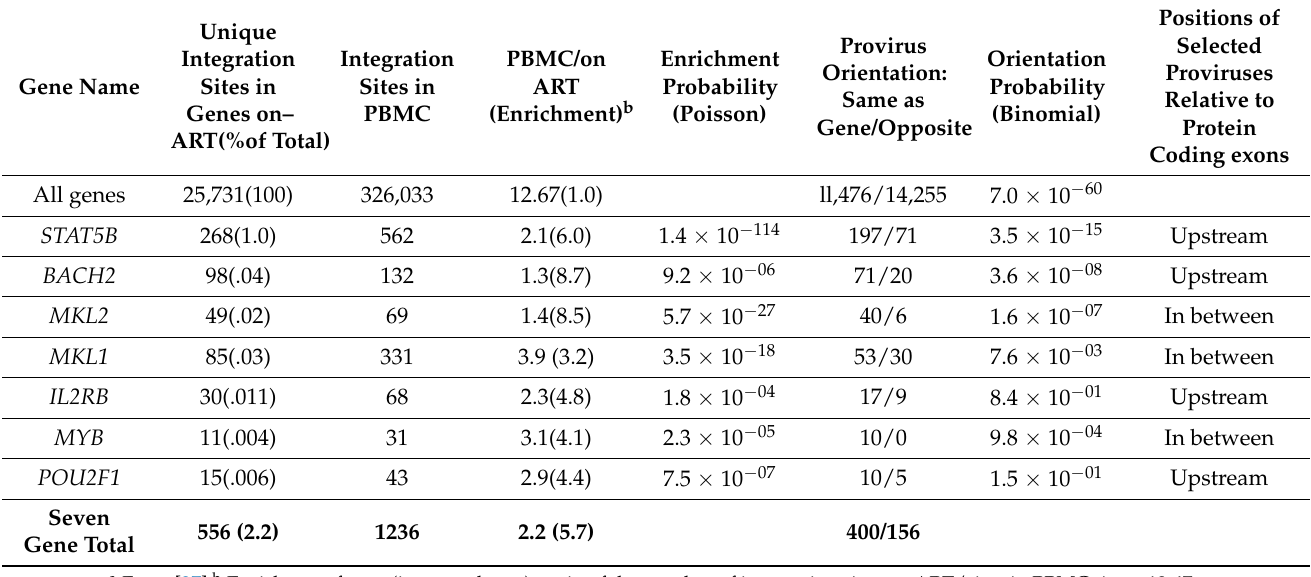
Table 1. Genes in which proviruses can provide a selective advantage a